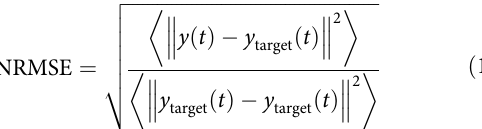
Supplementary Fig. 3. In every time interval τ , the output of RC system is the linear combination of all the reservoir states, where the weights are trained through simple linear regression method.